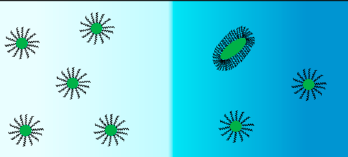
Figure 6. Two aqueous surfactant solutions with the same surfactant concentration but different salt concentrations are interfaced. The salt difference is portrayed as a color contrast for simplicity (left, low salt; right, high salt). The aggregate (elongated particle) depicted on the right side corresponds to the mass of three micelles. Consequently, the number of micelles on the left side (five) is higher than that on the right side (two).